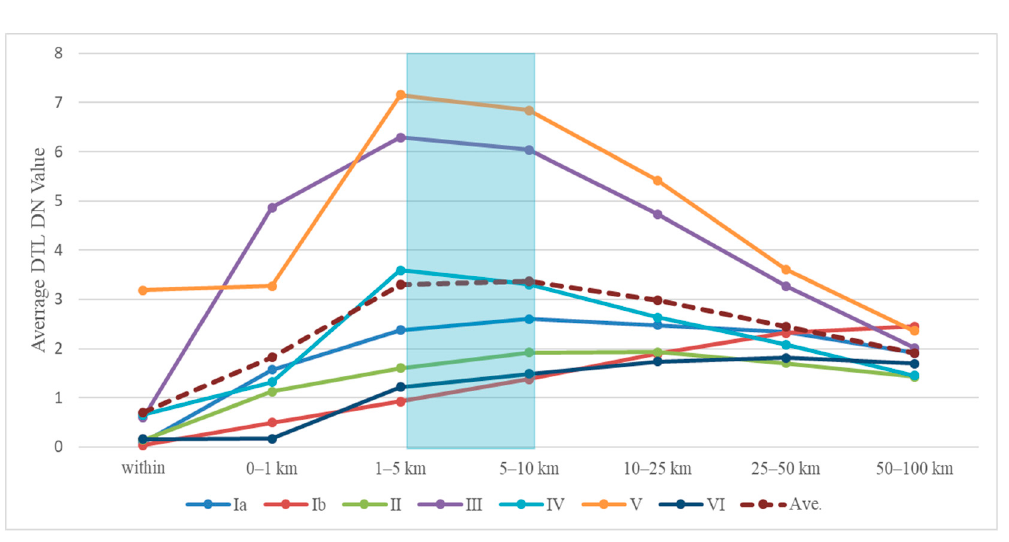
Table 2. NTL level of interior and buffer zones for the seven types of PAs.